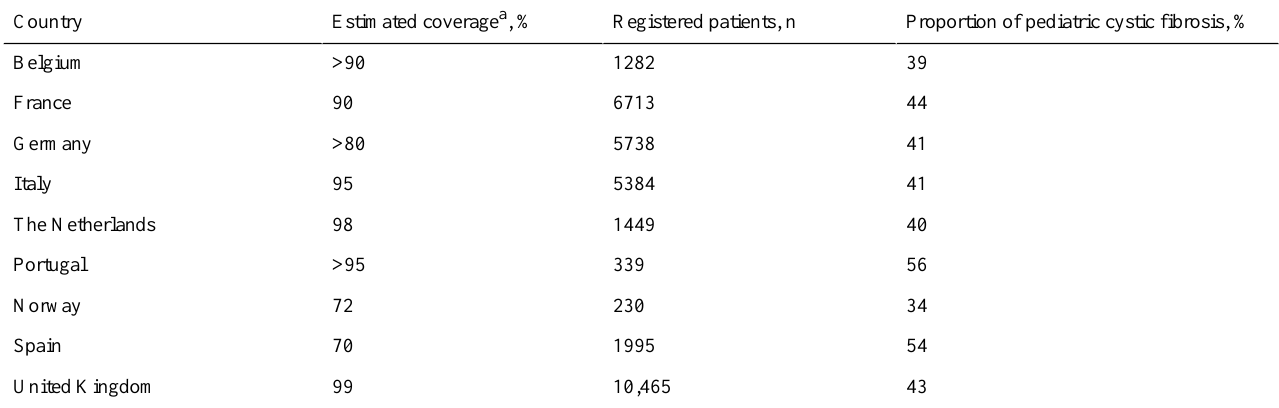
Table 1. Extraction of the estimated coverage, registered patients, and proportion of pediatric cystic fibrosis for the countries included in the study